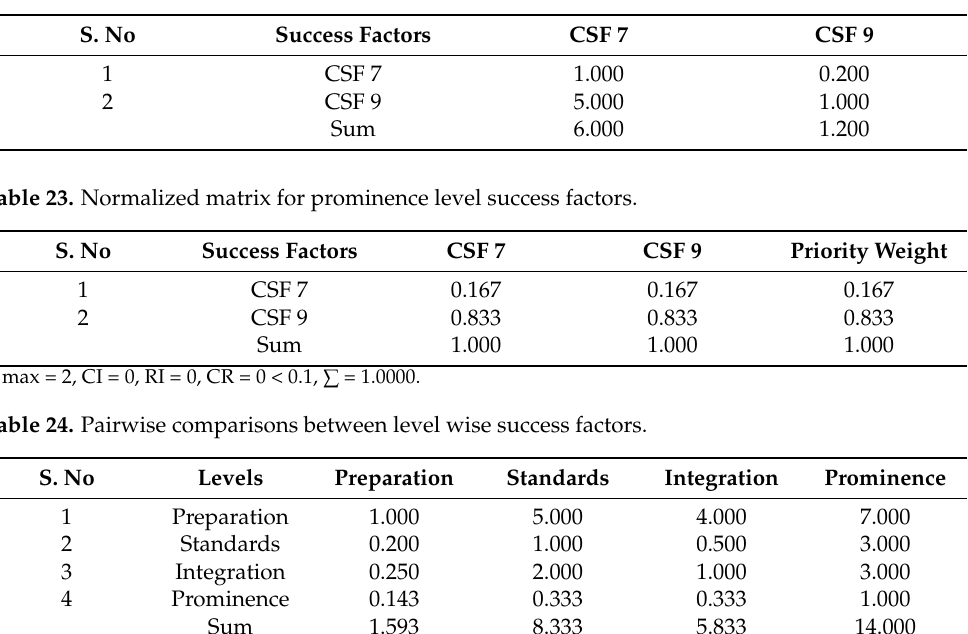
Table 22. Pairwise comparisons for prominence level success factors.